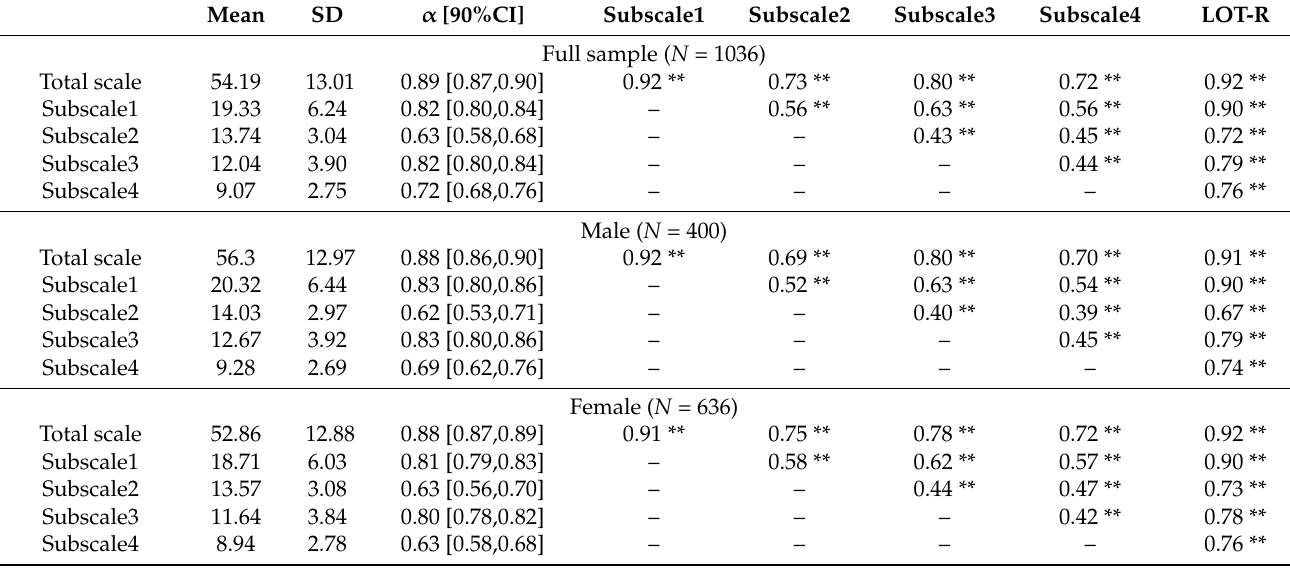
Table 6. Correlations between factors of the DERS and LOT-R according to the bifactor